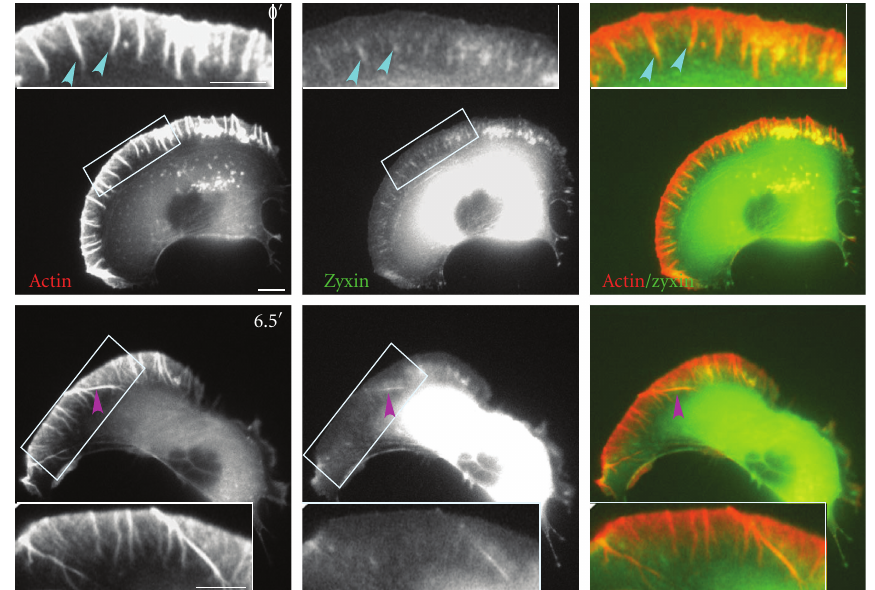
Figure 9: Lateral filopodia and adhesion proteins. Live cell time-lapse of a cell co-transfected with mCherry-actin and zyxin-GFP. Turquoise arrowheads indicate the localization of zyxin to the proximal end of stationary filopodia. Pink arrowheads indicate a lateral filopodium which is associated with zyxin along its entire length. White boxes indicate the areas that are enlarged in order to show the details of stationary and lateral filopodia. The entire movie can be found in Supplementary Data, Movie 11. Scale Bar 10 μ